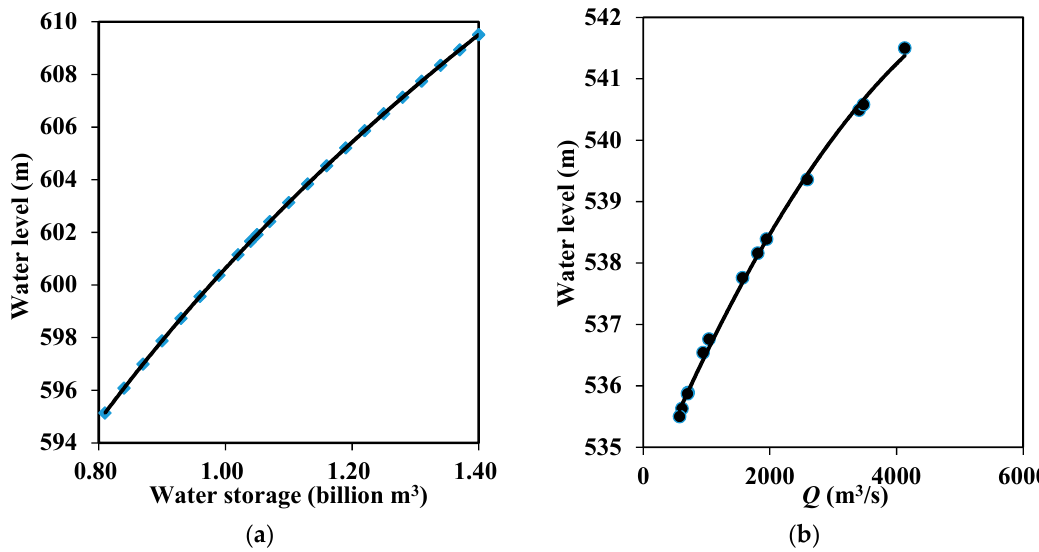
Figure 3. The functions g 1 (·) (shown as ( a )) for Jinghong reservoir and g 2 (·) (shown as ( b )) for the tail water at the Jinghong dam downstream site.